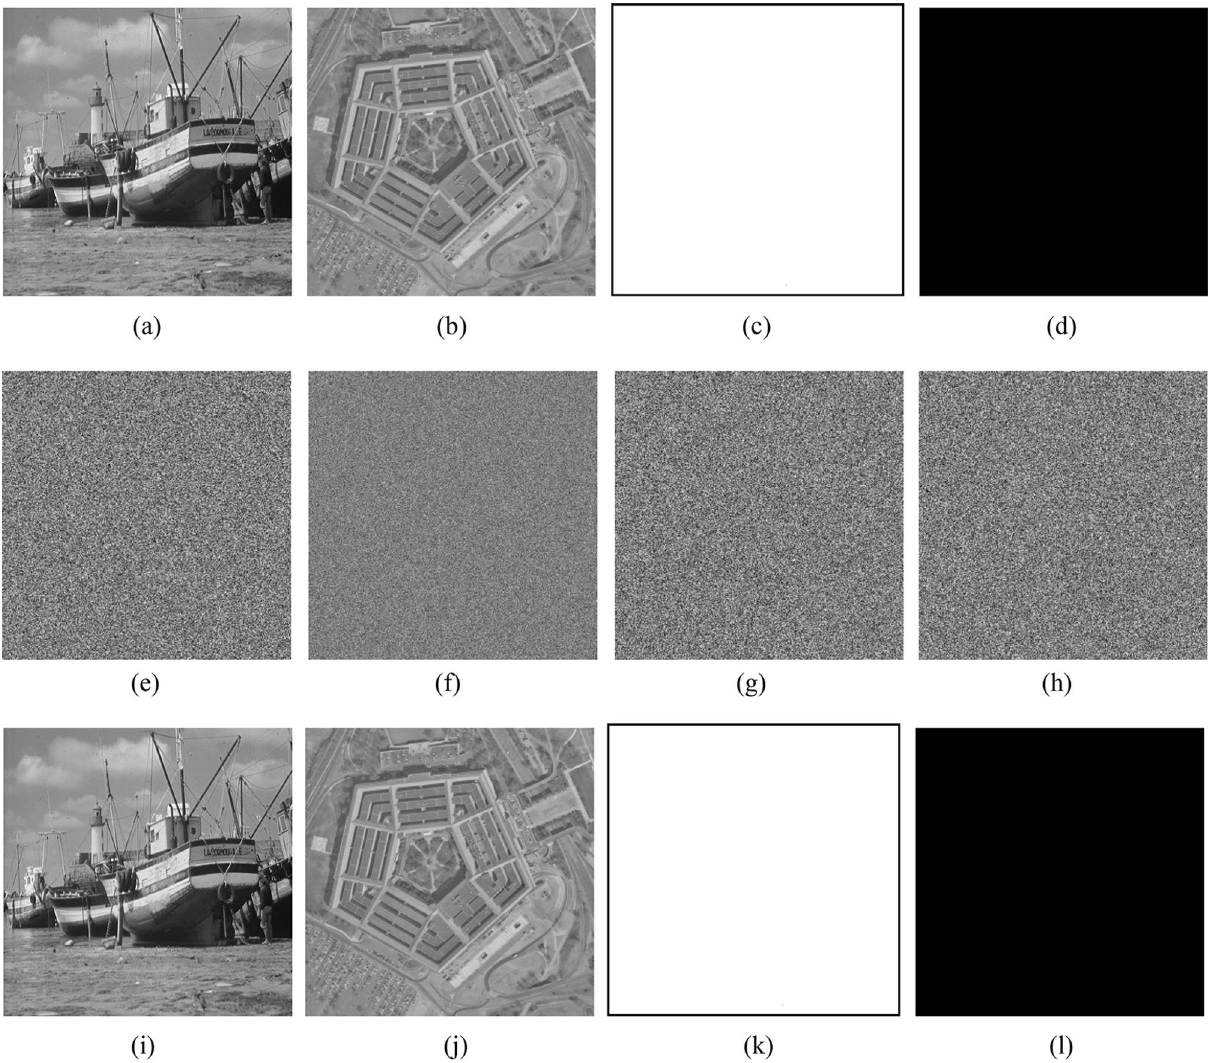
Figure 10. Encryption and decryption of images. ( a ) Original image of Boat.512, ( b ) original image of image 3.2.25, ( c ) original image of White, ( d ) original image of Black, ( e ) encrypted image of Boat.512, ( f ) encrypted image of image 3.2.25, ( g ) encrypted image of White, ( h ) encrypted image of Black, ( i ) decrypted image of Boat.512. ( j ) decrypted image of image 3.2.25, ( k ) decrypted image of White, ( l ) decrypted image of